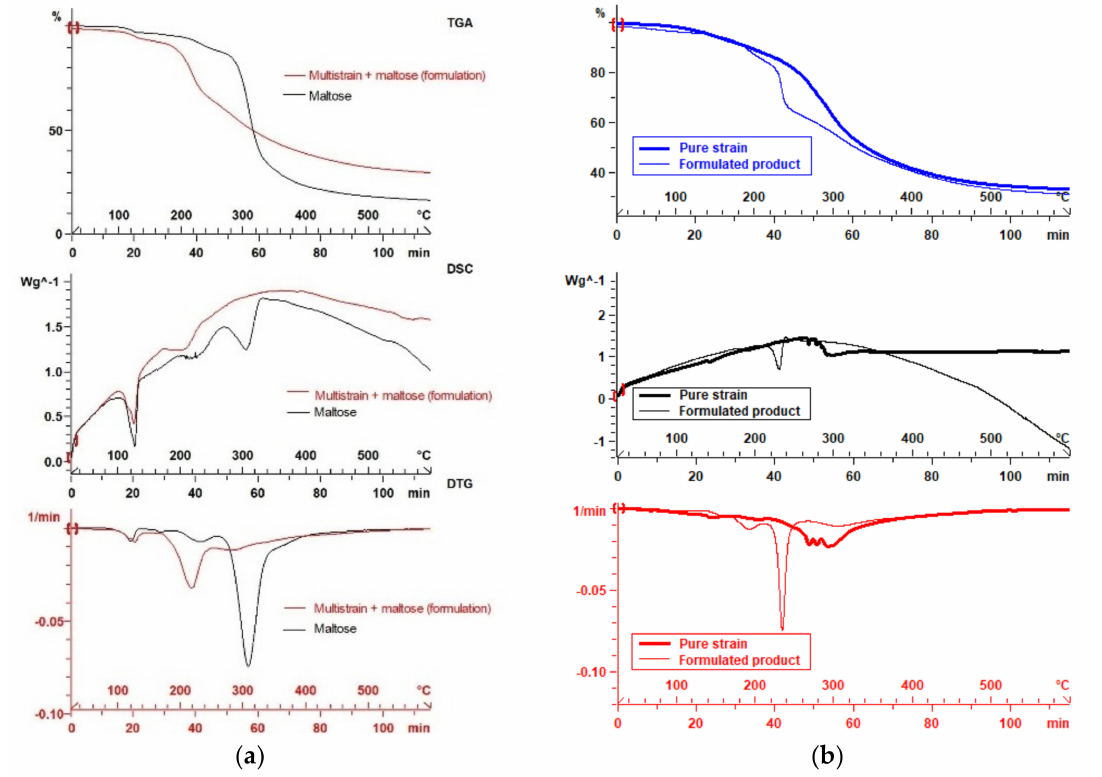
Figure 3. Thermal curves of ( a ) maltose-containing formulation vs. maltose and ( b ) pure vs. formu- lated L. plantarum